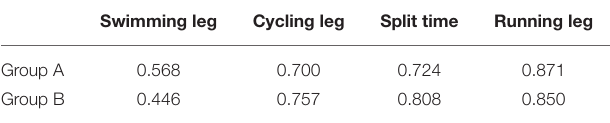
TABLE 2 | Correlation coefficient of total time and each leg time (rho). Swimming leg Cycling leg Split time Running leg Group A 0.568